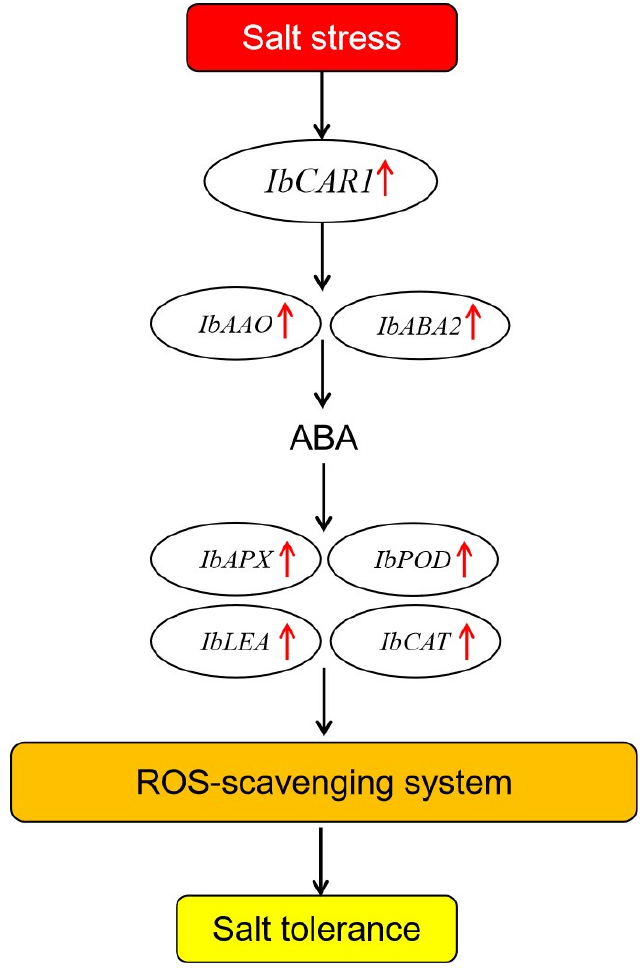
Figure 7. A proposed model for regulation of IbCAR1 in salt stress tolerance in transgenic sweet potato. Red arrows indicate up ‐ regulation of gene coding these enzymes.